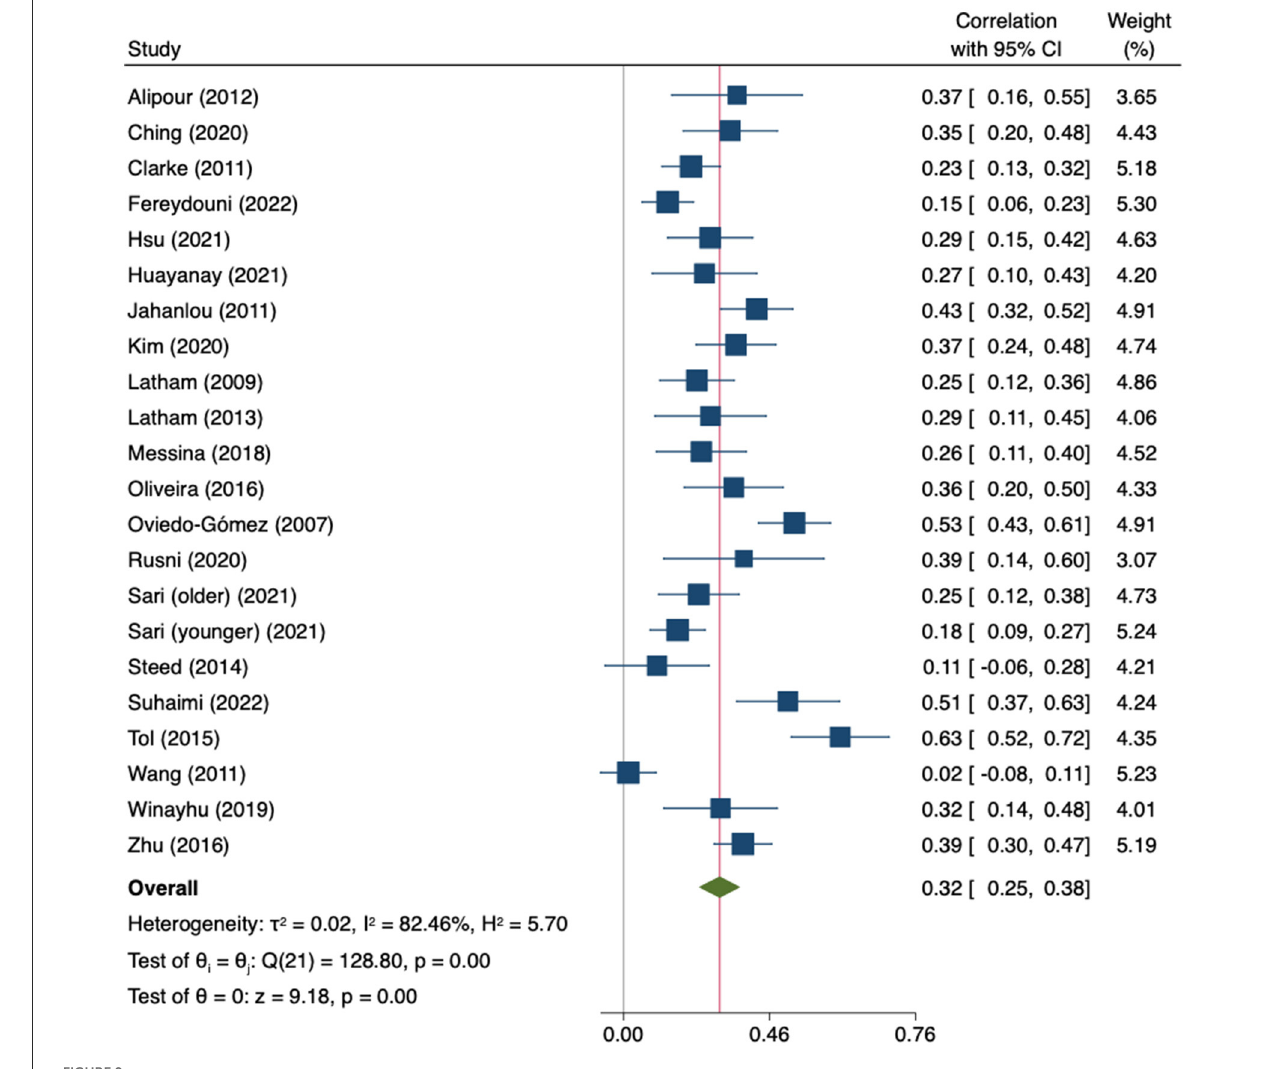
FIGURE9 Random-effects meta-analysis on the association between empowerment and general